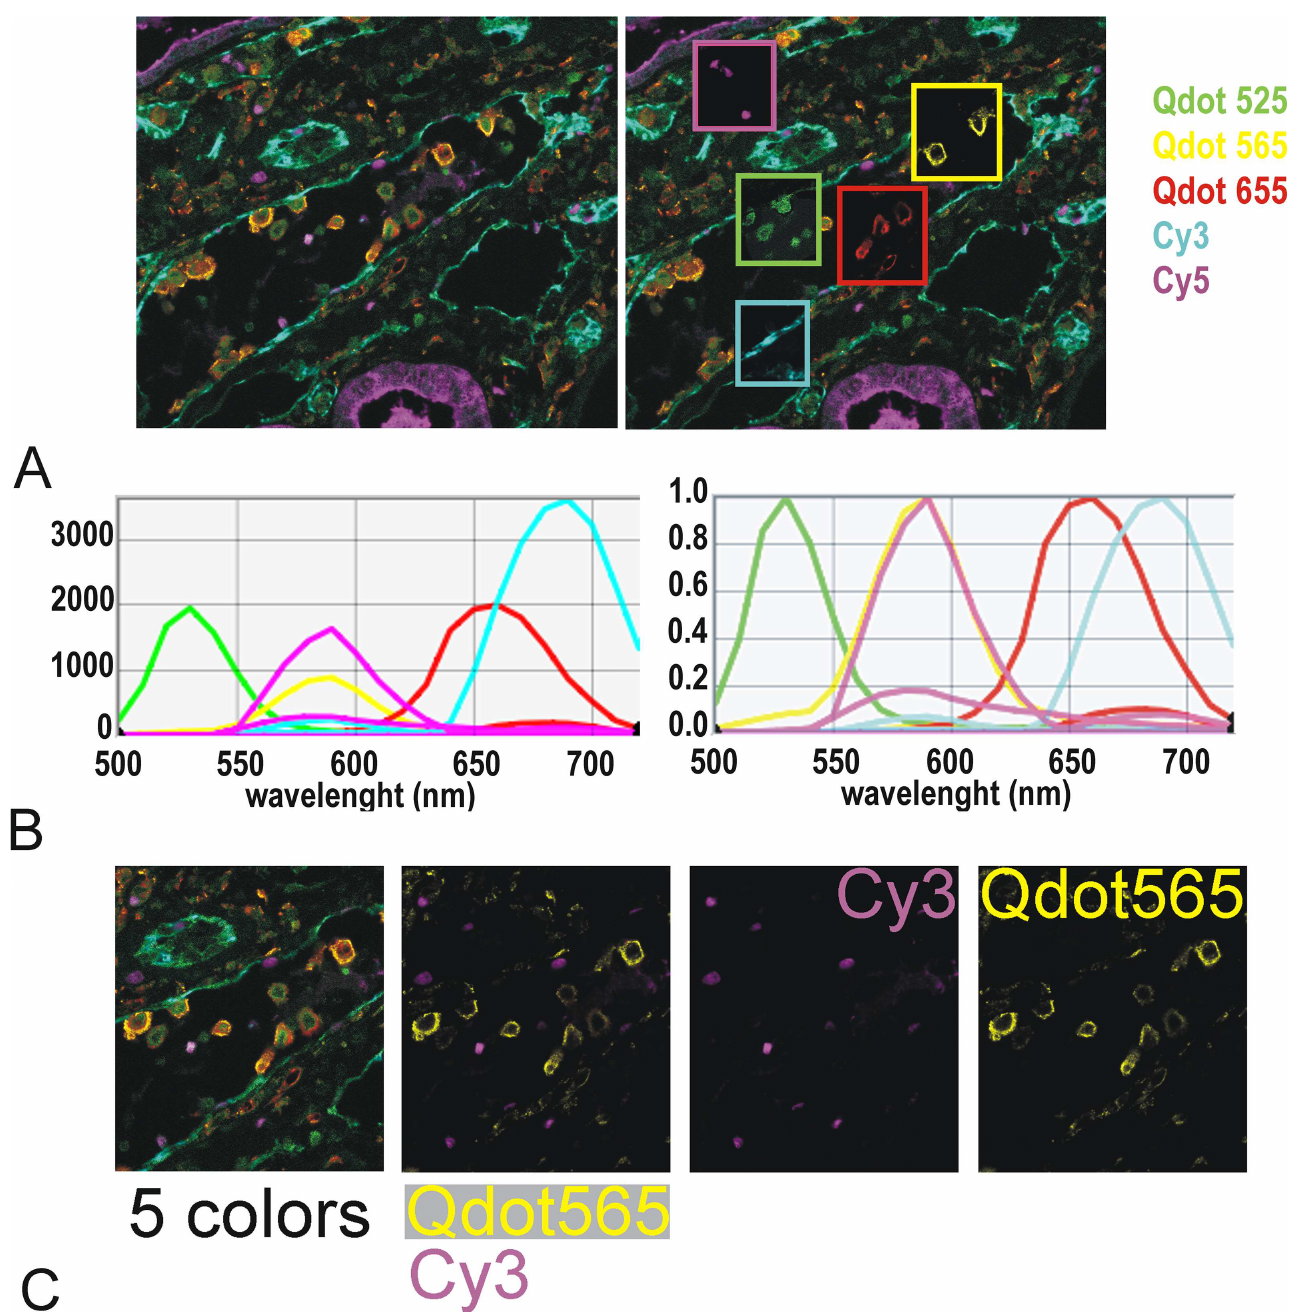
Fig 12. 5-colormultiplexusingQdot525,565, 655 & Cy3 & Cy5. The stainedFFPE section,illuminated with PE4000 single wave lengths(LAMs 435nm,550 &635 nm) was imagedusing Nuance Fx tunable camerabetween 500 & 720 nm throughCy3, Cy5 & Qdot filtercubes. The cube of imageswas unmixed according to single color spectra.A: left: unmixed image with all makers superimposed; false colors as indicated; right:same unmixed imageshowing in windows the individual unmixed markers. B: spectrallibraryused for the unmixing. Left:scaled to max; rightnormalised. The resultingspectra take into accountthe emissionof each fluorophore in each cube. The intensities of the dyes are of similarlevels with Cy3 being about twice as brightas the otherdyes (left).Note that althoughCy5 & Qdot 585 have a similarpeak of emission(yellow & magenta–right panel) Qdot 565 does not bleed throughCy3 filter(2 magentacurvesfor emission of Cy3 in both the Qdot& the Cy3 filterbut only one yellow curvefor emissionof Qdot 565 in Qdot filter).C: cube (5 colors)and unmixed imagesshowing an excellent unmixing of Cy3 (Ki 67 stainingin few nuclear cells) and Qdot565(CD68staining in